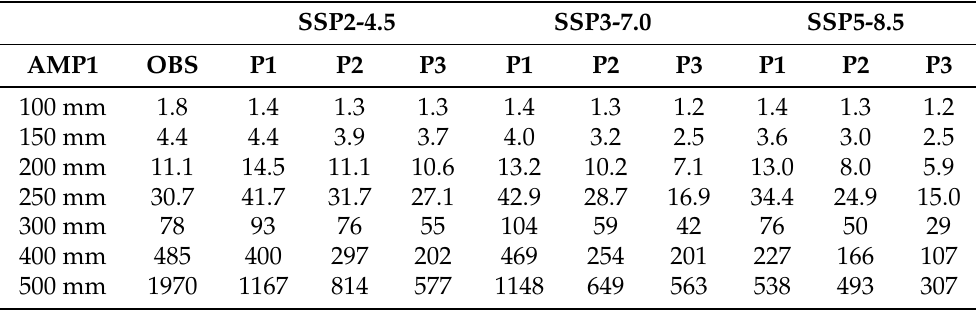
Table 2. The expected waiting time (unit: year) until reoccurrence or the return period of specific annual maximum daily precipitation (AMP1) values from 100 to 500 mm in the Korean peninsula obtained from the observations (OBS) and the CMIP6 model ensemble under the three SSP scenarios for the three future periods (P1, P2, and